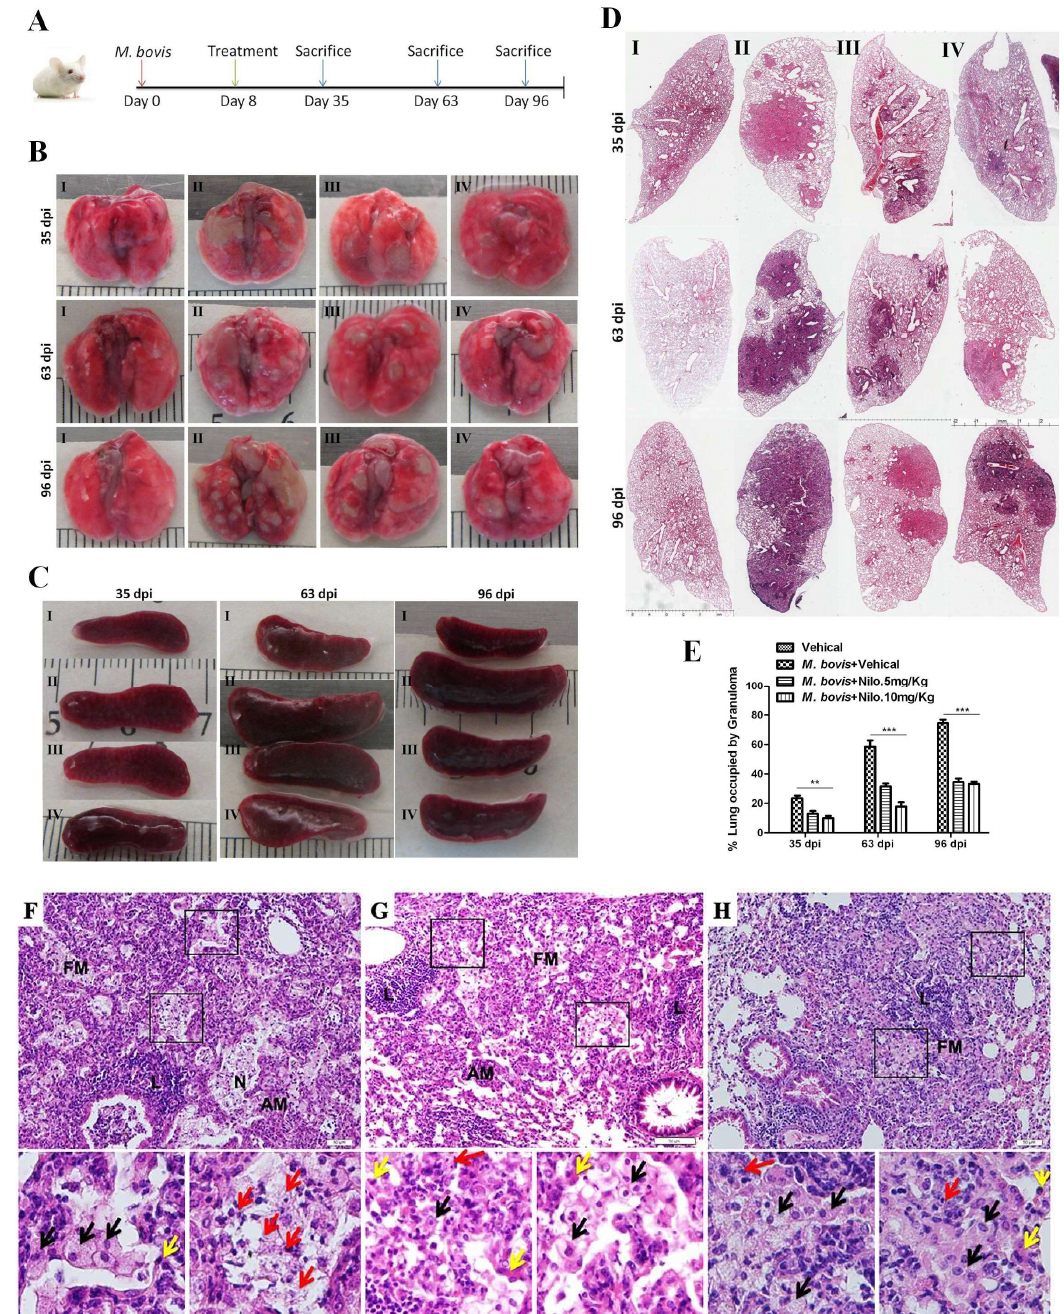
Figure 6. Nilotinib reduces the severity of M. bovis pathogenesis in mice. ( A ) BALB / c mice were infected with M. bovis at 200 CFU via the intranasal route; after one week of infection mice were treated with the vehicle (DMSO 30 µ L / mice), Nilotinib 5 mg / Kg, and 10 mg / kg via intraperitoneal (i.p.) injection on alternate dasy. On days 35, 63, and 96 after infection, animals were slaughtered and di ff erent organs plus blood serum were collected. ( B , C ) show the representative lung and spleen morphology of mice injected with the vehicle uninfected or infected with M. bovis followed by nilotinib treatment, as described above. ( D ) The representative left lung lobe of the vehicle injected uninfected or infected and nilotinib treated mice. ( E ) Area% of lung occupied by granuloma of uninfected mice injected with vehicle, infected, and nilotinib treated or untreated group ( n = 3). Statistical significance was determined by using a two-way analysis of variance (ANOVA) correcting for multiple comparisons. (** p < 0.001, *** p < 0.001). ( F – H ) Higher magnification of lung lesions (63 dpi) showing a characteristic dark stained lymphocyte dense area (L) next to a light stained foamy macrophages ring (FM),